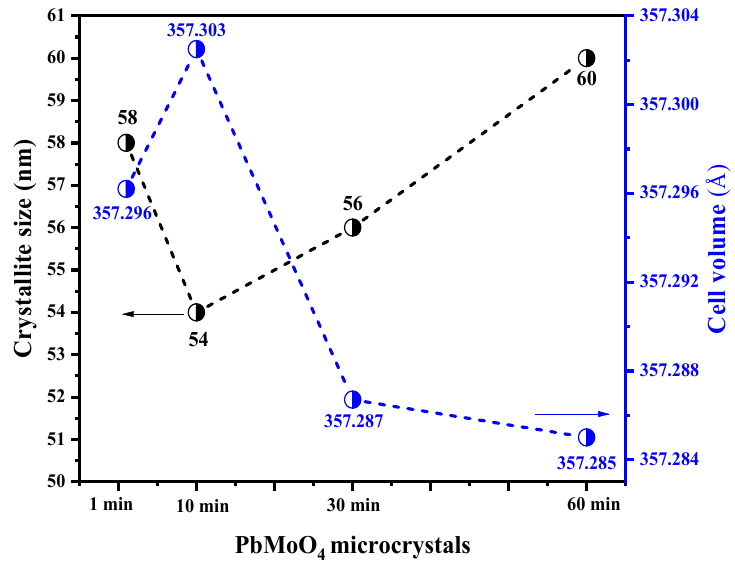
Figure 3. Crystallite size and unit cell volume of the PbMoO 4 nanocrystals obtained from the MH method for PbMoO 4 -1(1 min), PbMoO 4 -10 (10 min), PbMoO 4 -30 (30 min) and PbMoO 4 -60 (60 min).